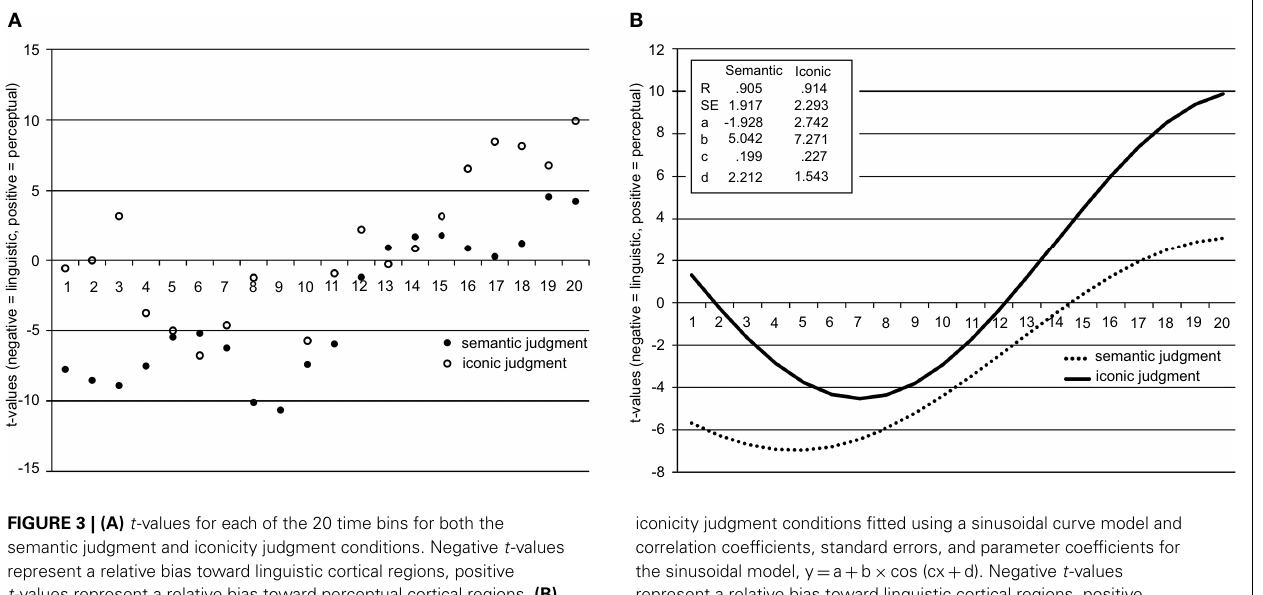
FIGURE 3 | (A) t -values for each of the 20 time bins for both the semantic judgment and iconicity judgment conditions. Negative t -values represent a relative bias toward linguistic cortical regions, positive t -values represent a relative bias toward perceptual cortical regions. (B) t -values for each of the 20 time bins for both the semantic judgment and